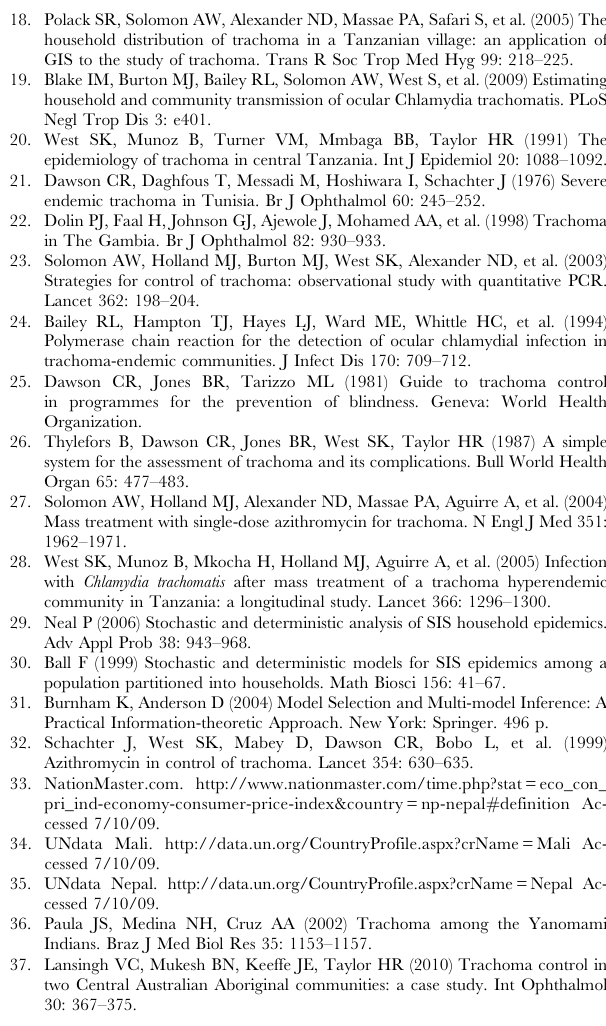
Table S3 Cost Data from Mali and Nepal summarised from [10] and [11].